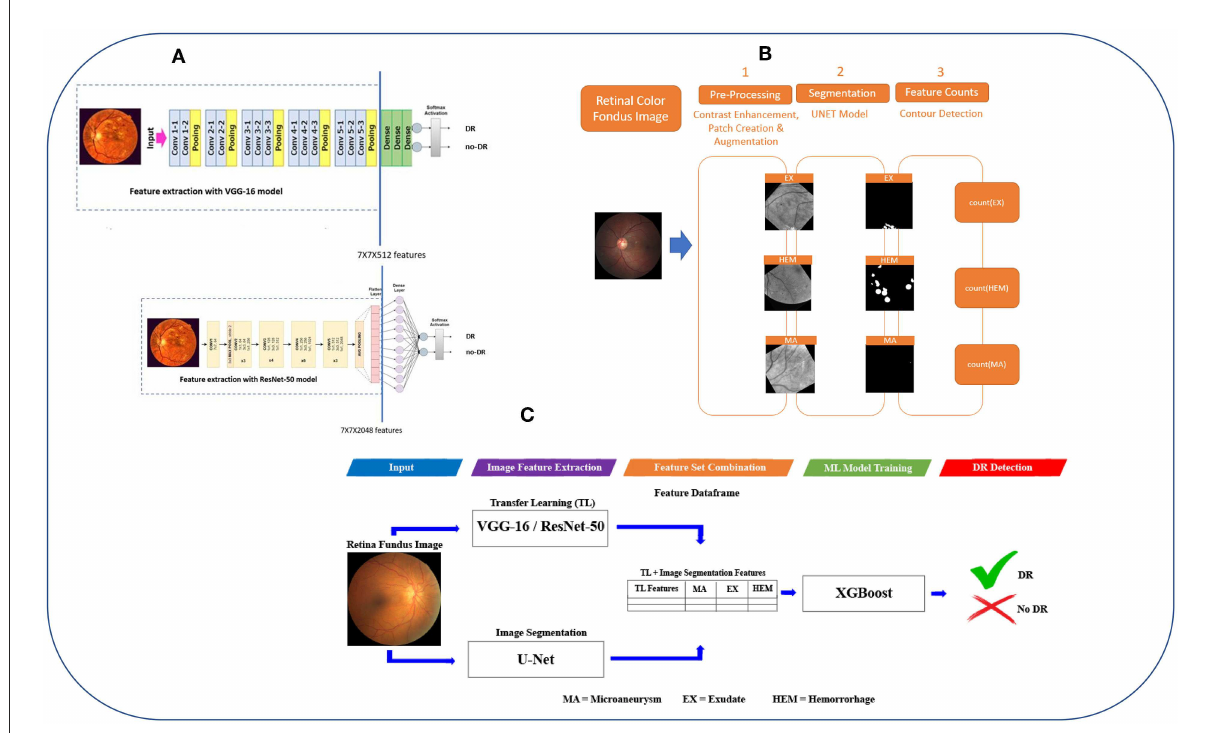
FIGURE1 The workflow of DR-detector framework for detection of DR using a combination of TL and lesion features. (A) Extracting TL features from VGG-16 and ResNet-50 models. (B) Extracting MAs, EXs, and HEMs lesion features from retinal fundus images using U-Net semantic segmentation models. (C) Flat combination of TL and lesion features in DR-detector